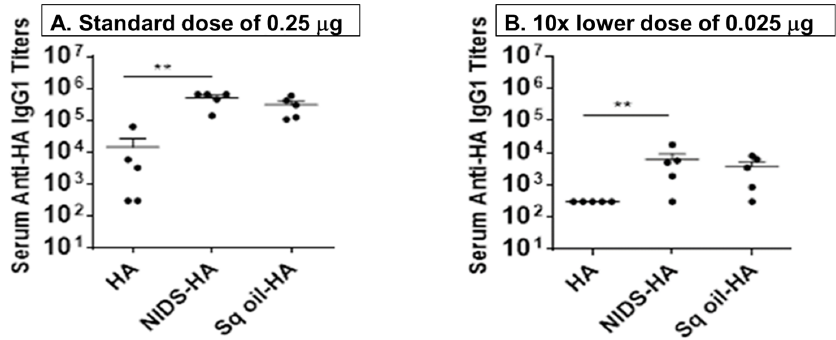
Figure 7. Dose sparing effects of NIDS compared to other adjuvants on antibody responses. ( A ) Serum anti ‐ HA IgG1 titers following two systemic vaccinations with the standard (0.25 μ g) dose of HA antigen measured by ELISA; ( B ) Serum anti ‐ HA IgG1 titers following two systemic vaccinations with 10× lower (0.025 μ g) dose of HA antigen measured by ELISA. The data are presented as mean values from five mice per group ± SEM (error bars). Each dot represents an individual mouse within a specific vaccination group. Statistical significance is represented as ** p < 0.01.